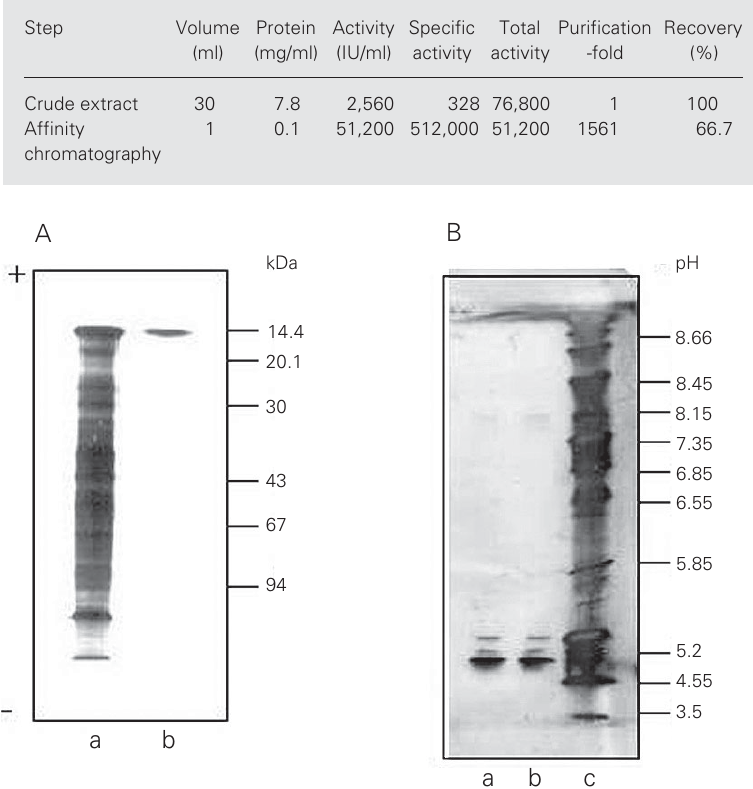
Table 2. Purification of cat liver galectin by affinity chromatography on asialofetuin- Sepharose.